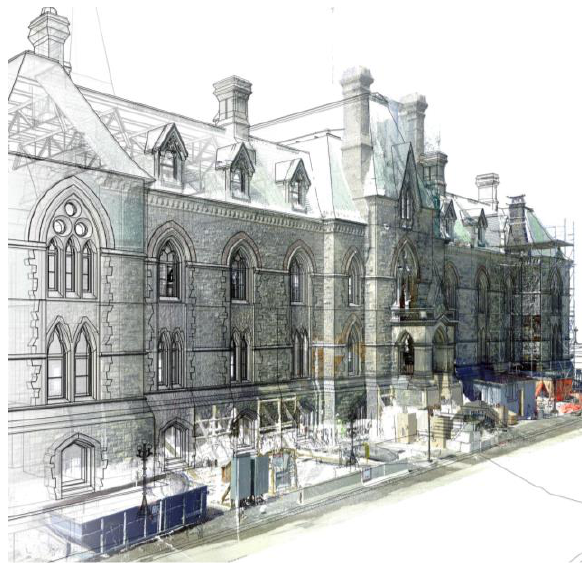
Figure 12. Results of the East Façade (LoD 3) of the BIM with point cloud